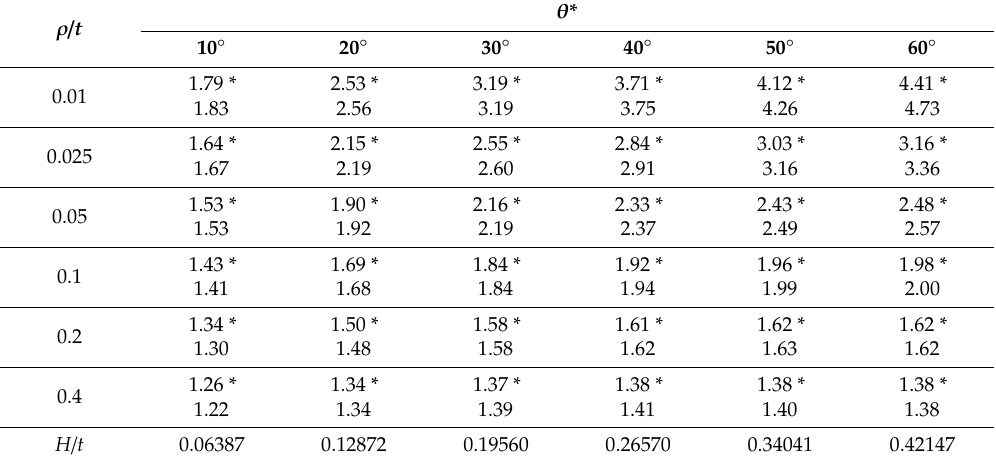
(16) for a Single-V butt-welded joint subjected to tension, when w / t = 1.46.